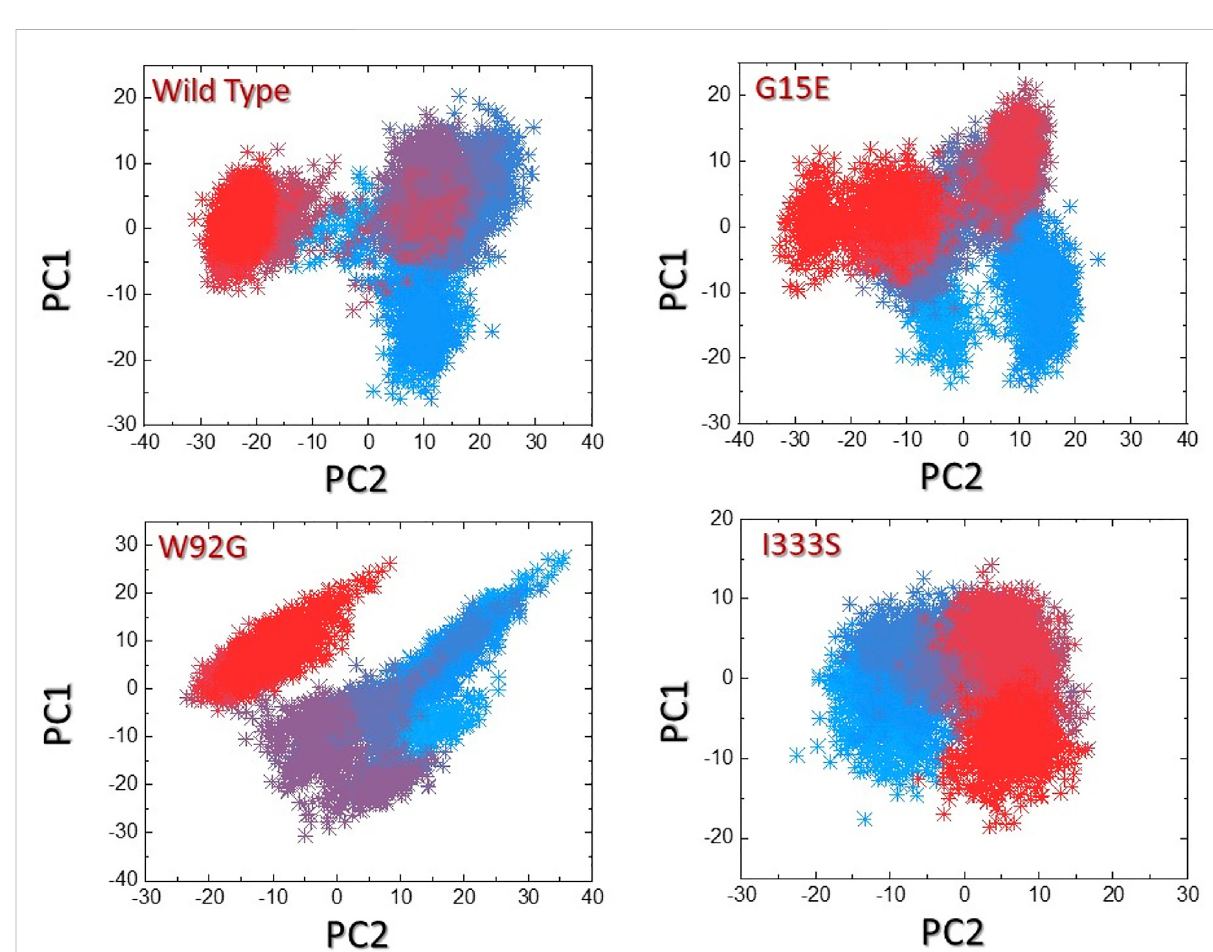
FIGURE 8 Principal component analysis of the wild-type and mutant complexes. (A ) Representation of PCA of the wild type. (B) Representation of PCA of G15E. (C) Representation of PCA of W92G. (D) Representation of PCA of I333S. The red to sky blue represent the different conformation states, whereas the transition states are represented by dark